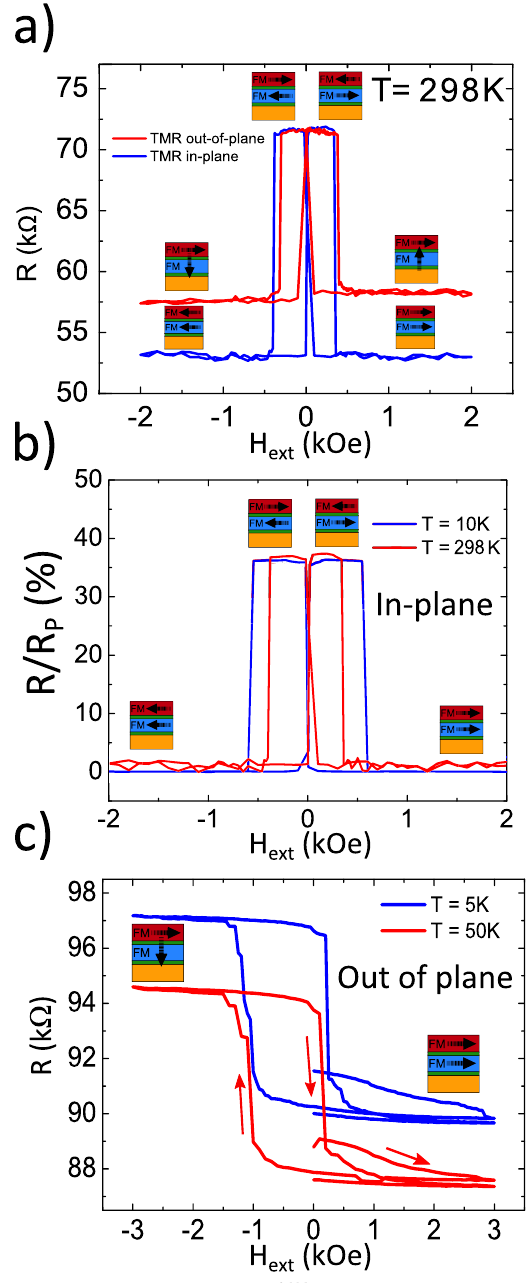
Figure 2. ( a ) In-plane and out of plane resistance vs. field curves at room temperature. Part ( b ) shows in-plane resistance (normalized by P state) vs. field curves for different temperatures. ( c ) Out of plane resistance vs. field curves at different temperatures. The coercive fields of the FM electrodes are higher in the out of plane direction ( −  H 1kOe and > − H 5kOe ). Red arrows indicate the magnetic field sweep C hard C soft